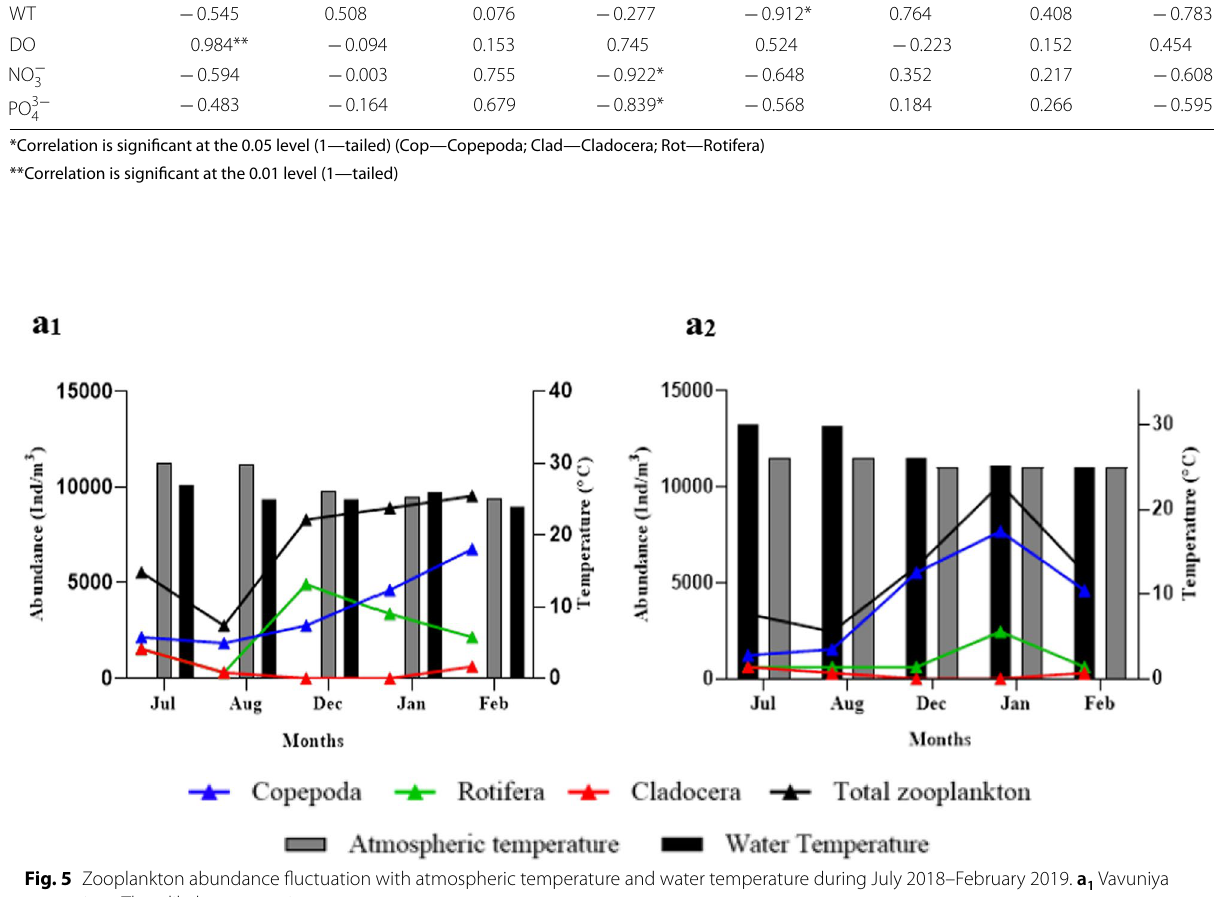
Table 4 Correlation coefficient values for zooplankton abundance with environmental parameters Parameter Correlation coefficient values ( r ) for Zooplankton abundance (Individual/ m 3 )